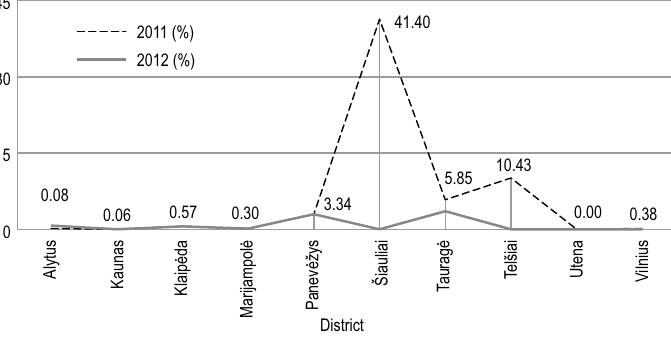
Fig. 9. Insufficiently treated wastewaters releases into surface waters in the districts of Lithuania during the period